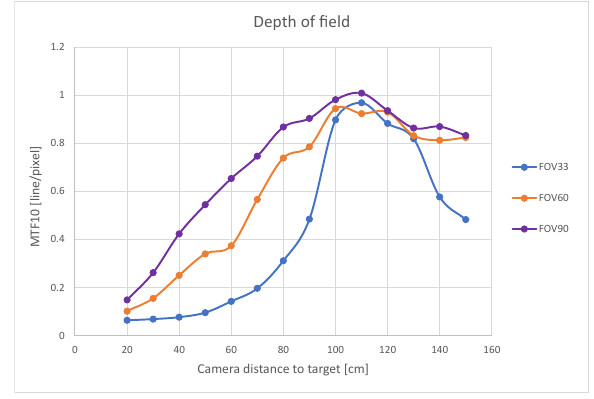
Figure 10. Upgraded chessboard for trifocal calibration. Improved LWIR contrast on our board with FOV 90 ◦ (a) and faint contrast on a previous version of the board with FOV 33 ◦ (b).